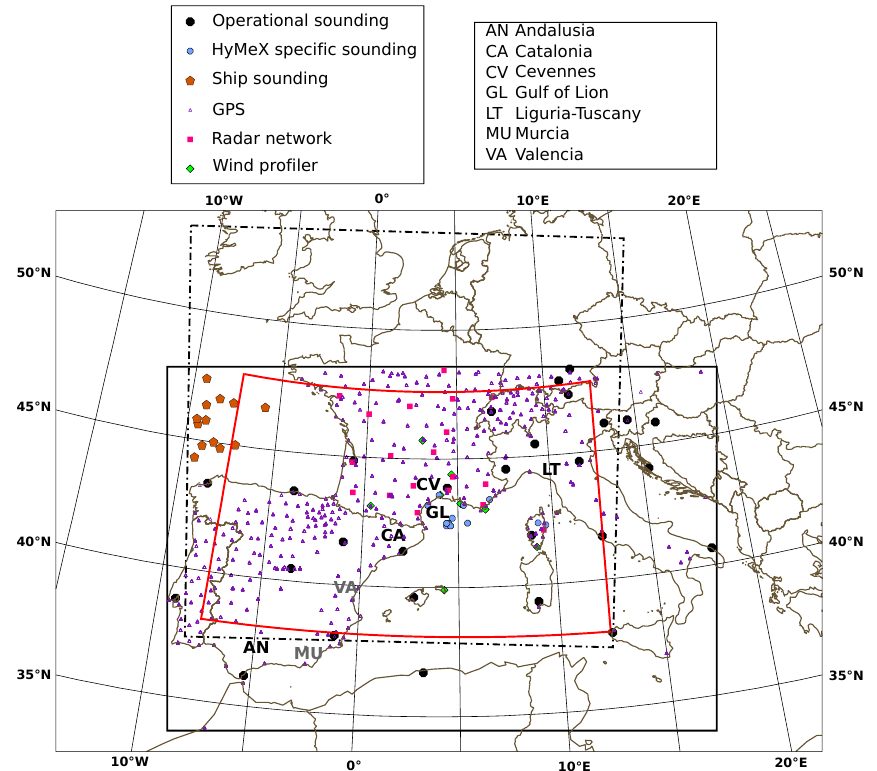
Figure 1. Location of various observation types assimilated in the AROME-WMED model represented with symbols and domains of AROME-WMED (solid line box) and AROME-France (dashed dotted line box). The red rectangle represents the verification area.